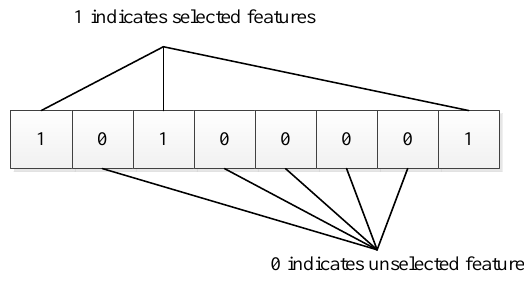
Figure 4. Representation of a firefly.